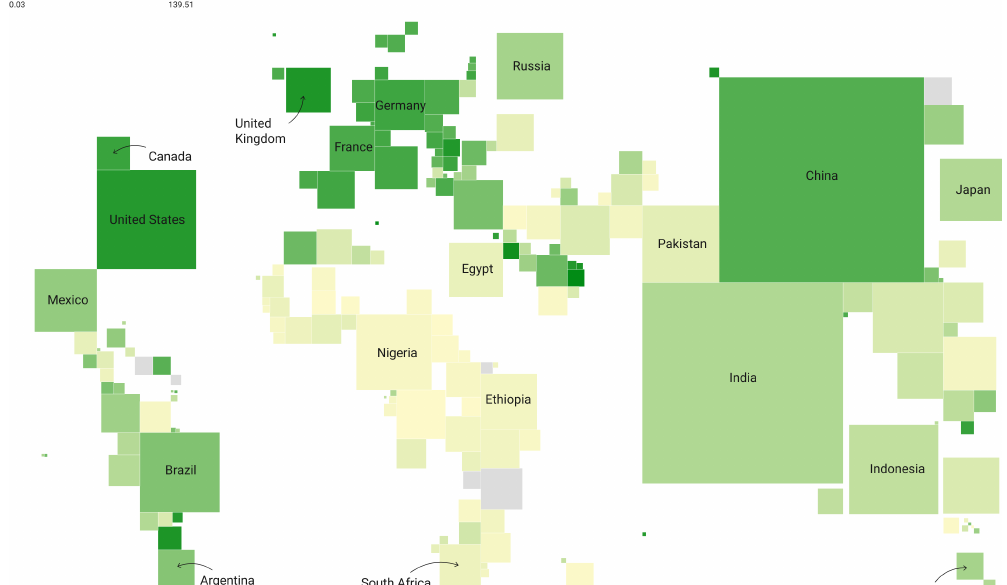
Fig. 2 Cumulative number of COVID-19 vaccines per 100 people on June 10, 2021. The bigger the country or region’s population, the bigger the square. Darker colors indicate higher numbers of people vaccinated per 100 people. The number of recorded vaccinations is likely to be lower than the actual number of vaccinations, mainly due to limited testing and time